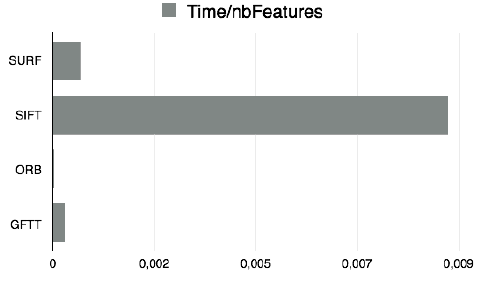
Figure 9: Execution time for different detectors (in